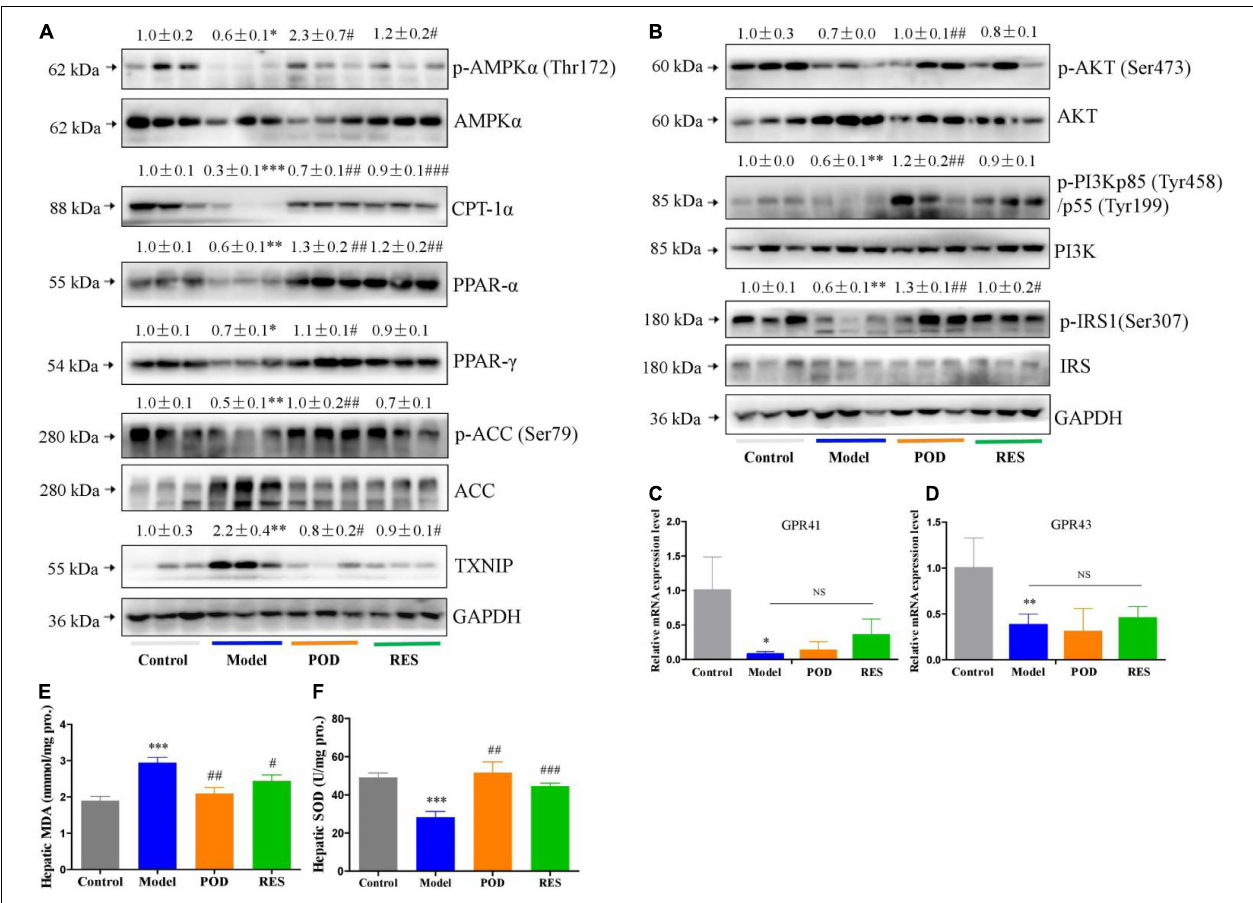
FIGURE 4 | Effects of POD and RES on AMPK signaling pathway and biomarkers of oxidative stress in liver. (A) AMPK signaling pathway proteins. (B) Insulin signaling pathway proteins. (C,D) The mRNA levels of GPR41 and GPR43. (E) MDA level. (F) SOD enzyme activity level. Data are presented as mean ± SEM. ∗ p < 0.05, ∗∗ p < 0.01, ∗∗∗ p < 0.001, compared to control group. # p < 0.05, ## p < 0.01, ### p < 0.001, compared to model group. NS, p >